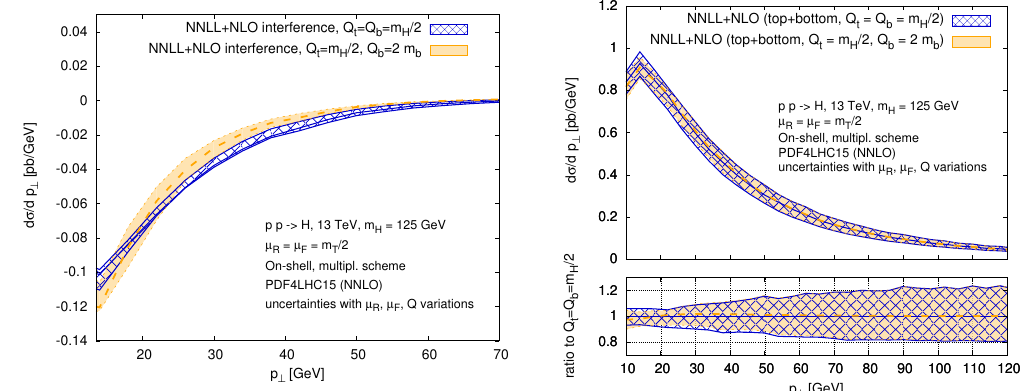
Figure 2 . Comparison between two resummation-scale prescriptions for top-bottom interference (left) and full (right) distributions. See text for